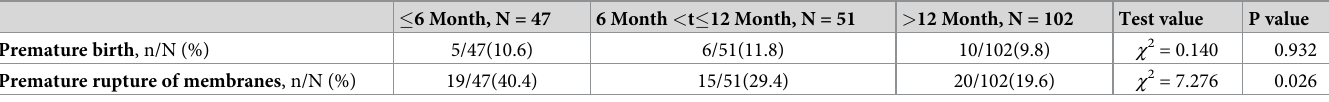
Table 3. The impact of postoperative pregnancy intervals (t) on preterm delivery and premature rupture of membranes.